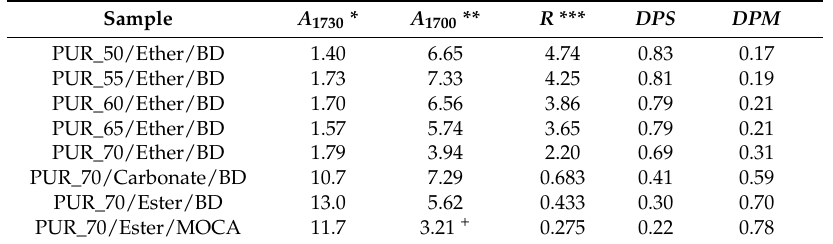
Figure 6. FT-IR spectra of PUR with the various chemical compositions. Contents of the SS for all materials is constant. Table 4. The carbonyl hydrogen bonding index ( R ), the degree of the phase separation ( DPS ), and the degree of the phase mixing ( DPM ) in the prepared PUR.